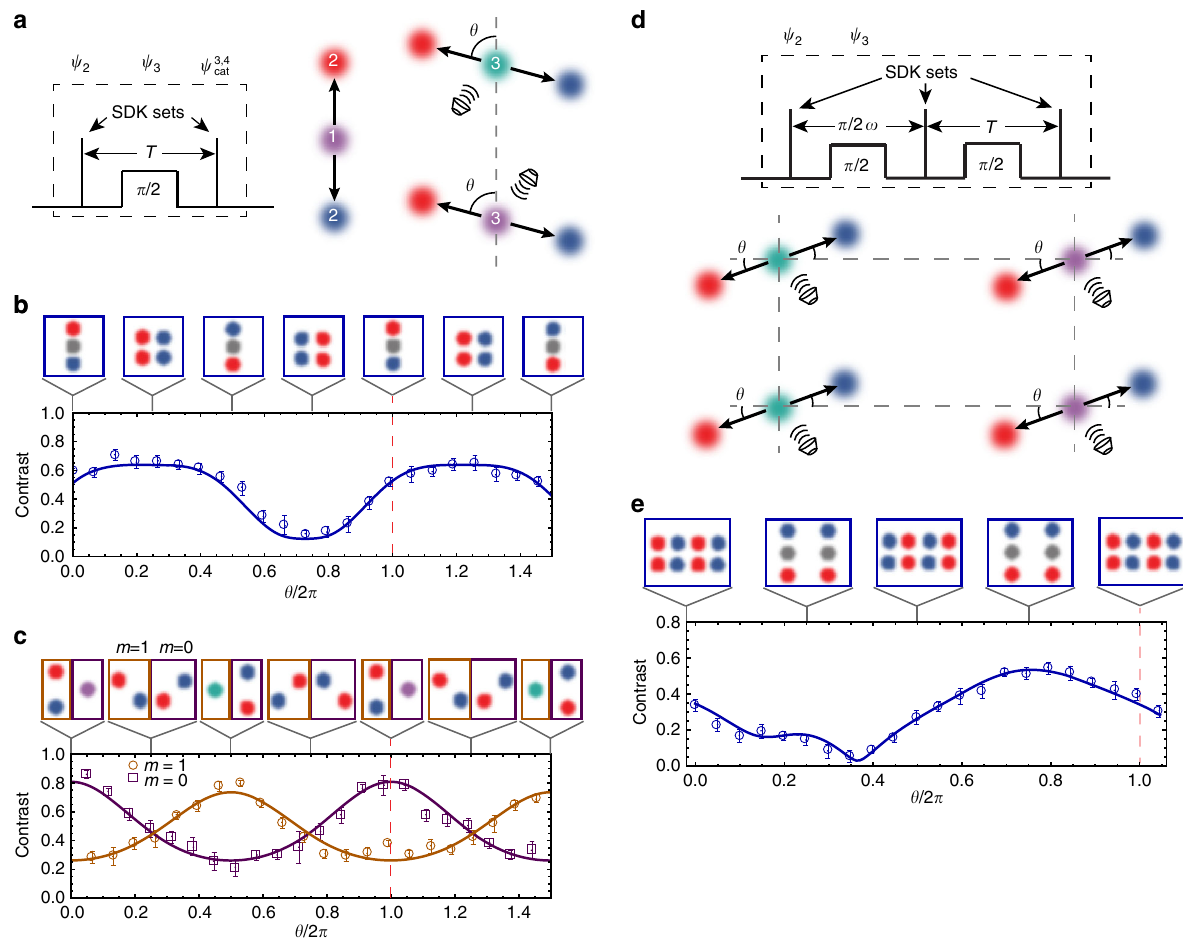
Fig. 4 Three-, four-, six- and eight-component states. a Creation of a multicomponent state begins by applying a set of SDKs to take the state ψ 1 j i (1) to the state ψ 2 j i (2). A microwave π /2 pulse rotates the qubit to produce the state ψ 3 j i ¼ "j i (cid:3) #j ið Þ α j i þ "j i þ #j ið Þ (cid:3) α j i (3). Another set of SDKs generates the three- or four-component state. The diagram within the dashed box replaces the one in Fig. 1a for these experiments. b If θ = 0, two of the components rejoin and the state has the form α j i þ 0 j i þ (cid:3) α